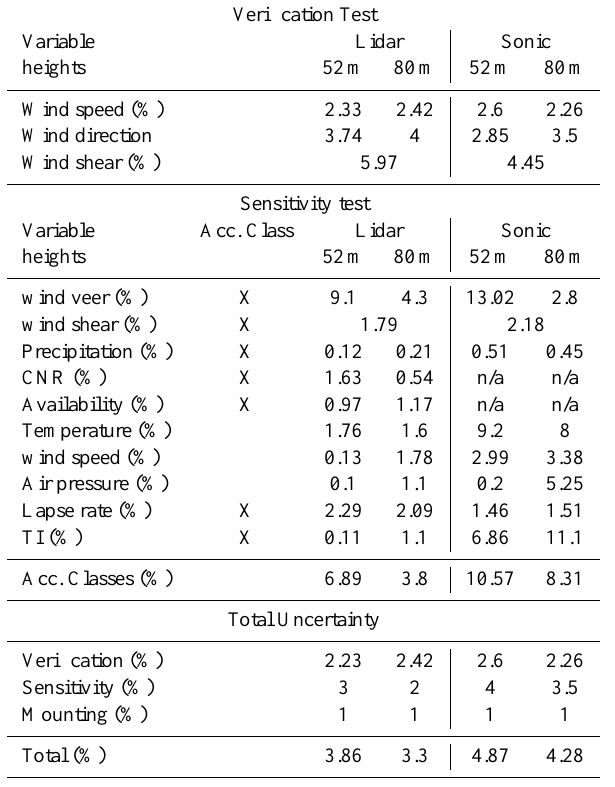
Table 2. Verification tests and Sensitivity tests for MM3 for Lidar and sonic anemometer when compared against the reference cup anemometer. The accuracy classes are approximated according to the CD-IEC 61400-12-1 Ed.2 description in Albers et al. (2012). The variables counted in the uncertainty are crossed for